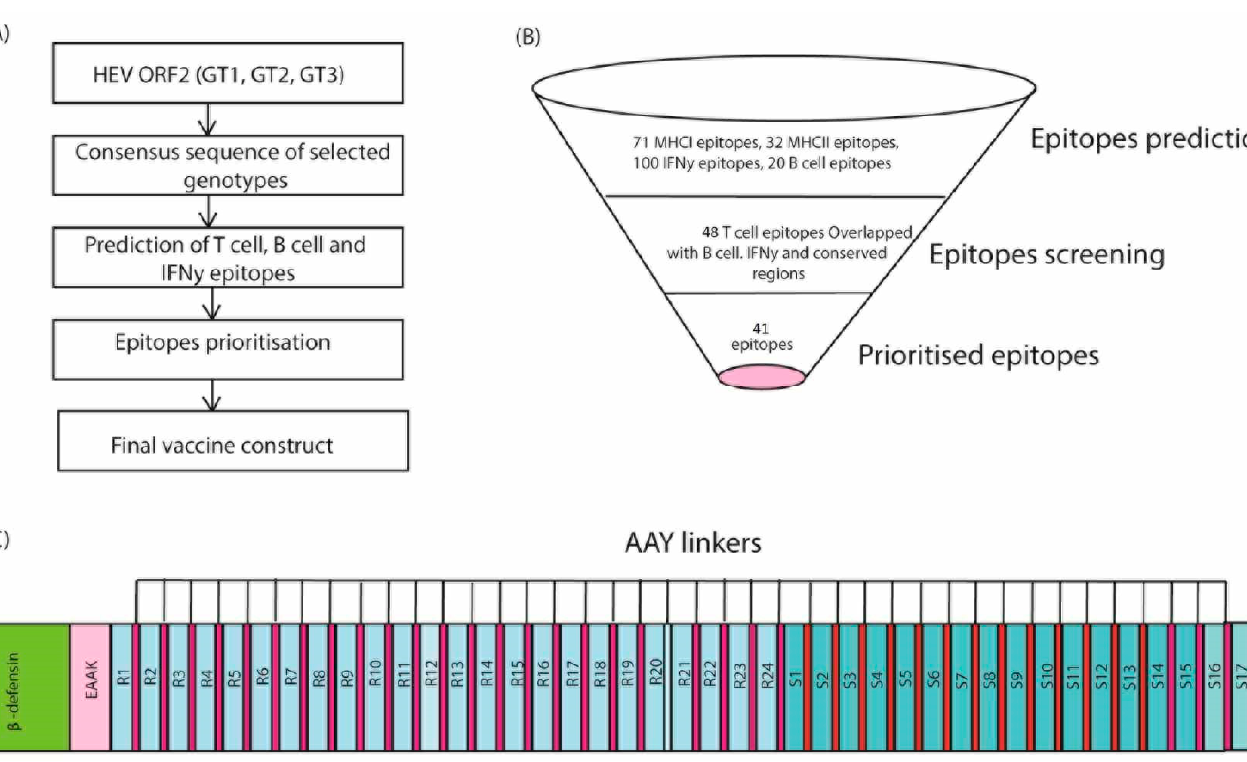
Figure 2. Predicted 3D structure and validation of multi-epitope vaccine constructs ( A ) Vu; universal vaccine construct ( B ) Ramachandran plot showed that 88.3% (Vu) of the proposed vaccine constructs residues were present in favored regions. ( C ) ProSA-web results indicated a Z-score of ‒ 0.86.